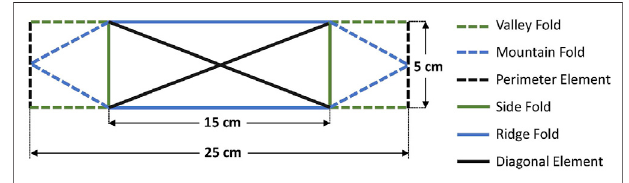
Frontiers in Built Environment |